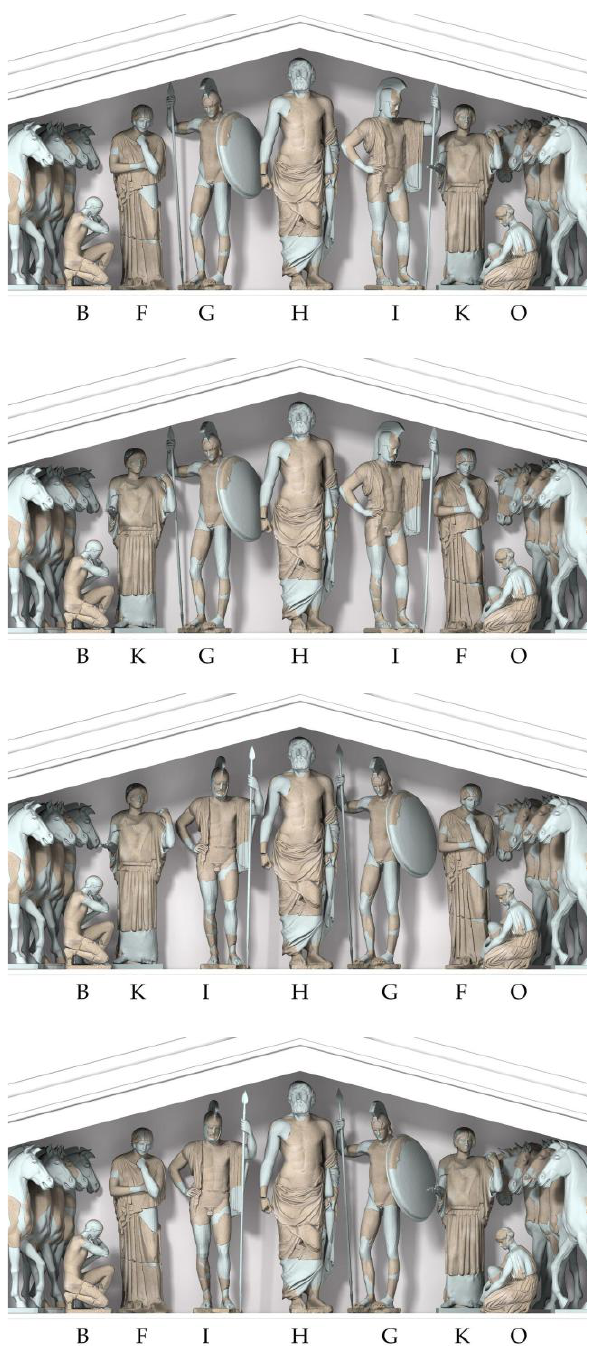
Figure 10. Virtual 3D reconstructions of the central figures arranged as in Figure 2. The fragments are displayed in grey, the reconstructed parts in pale blue The model shows, however, that the arrangement, which was considered to be physically impossible in the 19th century (open “A”) and which is most commonly accepted today (Figure 3, 7), is indeed the most difficult to realize: the limbs of figure K and G do not necessarily run across each other, but the distance between them is so small (max. 10 cm) that we can hardly believe that this arrangement could follow the original intentions of the designers or the sculptors. (Figure